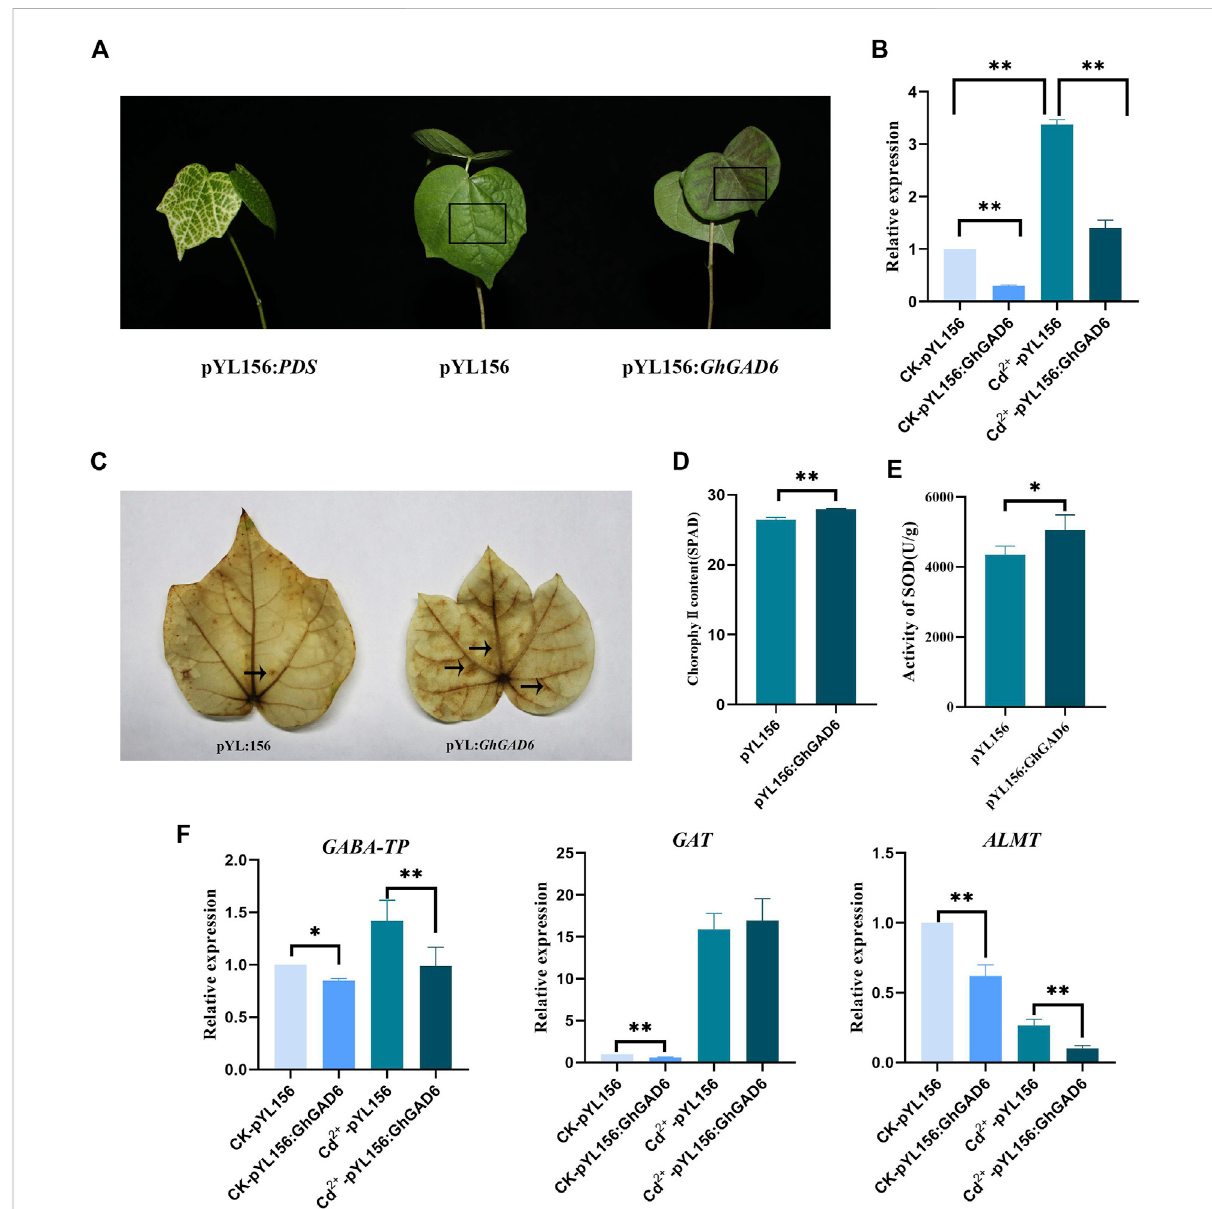
FIGURE 11 Silencing GhGAD6 via VIGS increased sensitivity to Cd 2+ stress. (A) The phenotype of cotton after GhGAD6 gene silencing under Cd 2+ stress. pYL156: PDS as a positive control, pYL156 was an empty vector as control, and pYL156: GhGAD6 was GhGAD6 silenced lines. (B) The relative expression level of GhGAD6 under water and Cd 2+ stress. (C) DAB staining. (D) Chlorophyl Ⅱ content of empty control and VIGS plants under Cd 2+ stress. (E) SODactivityofemptycontrolandVIGSplantsunderCd 2+ stress. (F) DetectionofgeneexpressionofGABAshuntinGhGAD6silenced lines. The blackbox represents thedarkening oftheleaf veins,theblack arrows indicate thelocation ofH 2 O 2 generation.*0.01 < p < 0.05, ** p <